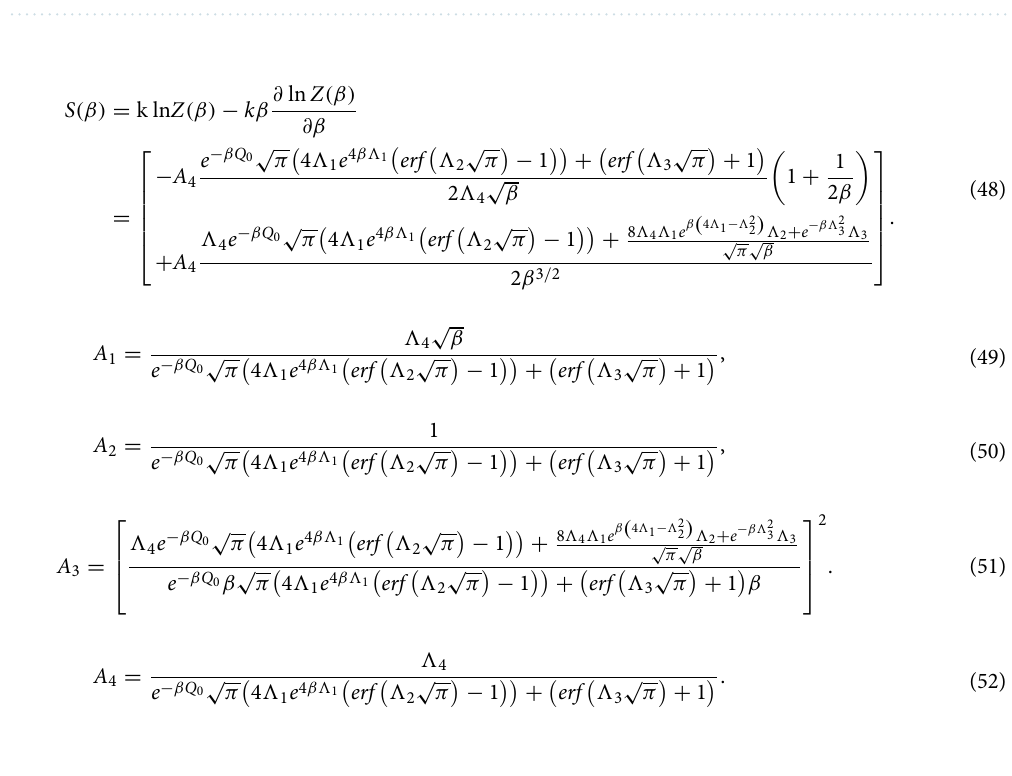
Figure 2. Energy E n , ℓ against the C h with µ = (cid:31) = ℓ = 1, b h = 0.5 Å, r e = 0.5 Å, b = 0.001 Å and D e = 10 eV